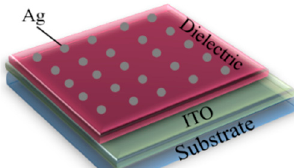
Figure 6. MIM (metal-insulator-metal) sketch map of Zr–AlO x films.